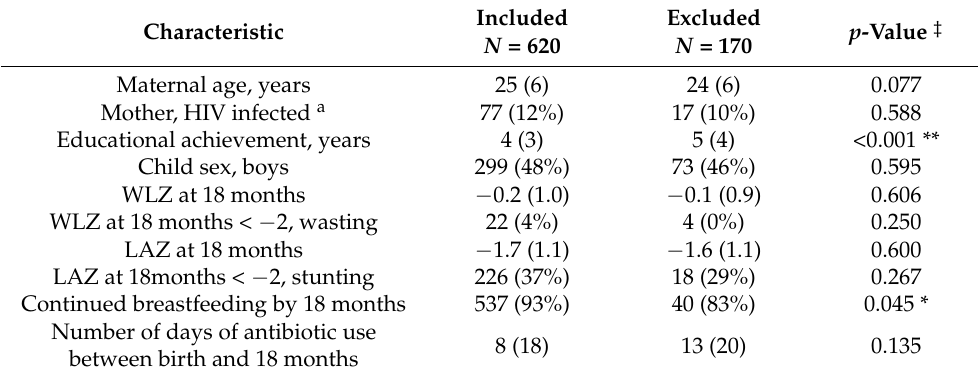
Table 1. Characteristics of participants included and excluded † .